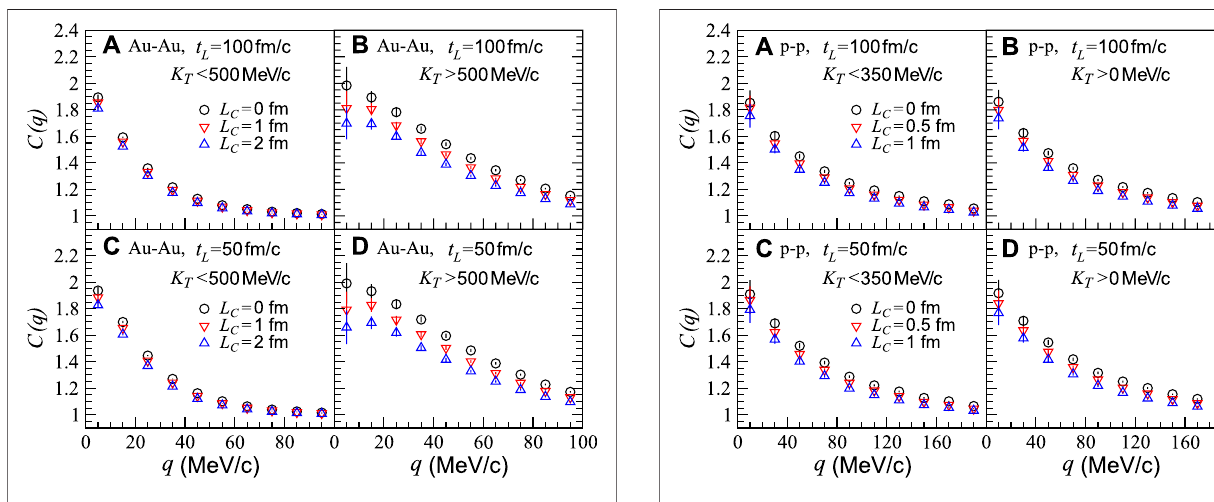
FIGURE 3 | Two-pion correlation functions C ( q ) for pion-emitting sources with different coherent emission length values, L C , in the transverse momentum ranges of K T < 350 MeV/ c and K T > 0 MeV/ c , respectively, in p-p (cid:1) √ (cid:3) 13 TeV. Panels (A,B) apply to the temporal collisions at s